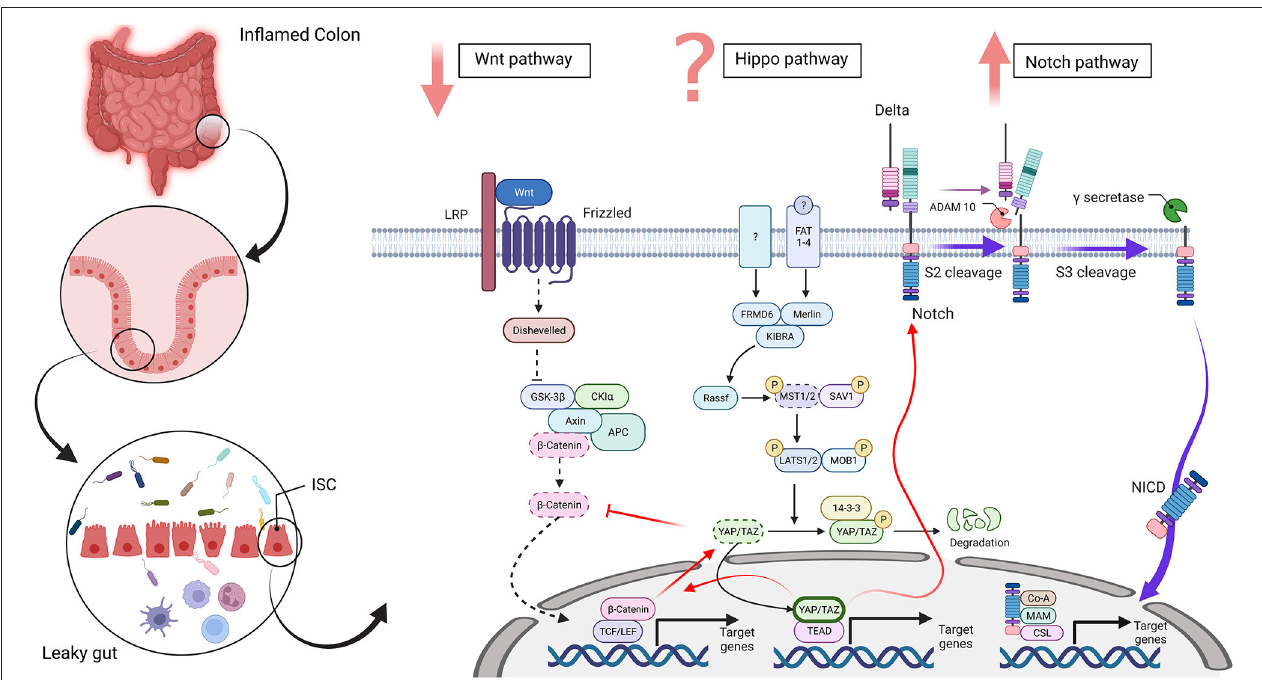
FIGURE 1 | Wnt, Hippo, and Notch signaling in an intestinal stem cell [inflammatory bowel disease (IBD) condition]. The disrupted intestinal epithelial barrier promotes a leaky gut in inflammatory conditions, such as IBD. In this state, differentiation-related pathways, such as Wnt, Hippo, and Notch, are dysregulated in intestinal stem cells. The Wnt signaling pathway plays a vital role in the intestinal epithelium and downregulation of β -catenin disrupts the differentiation of secretory cells in IBD. The Hippo pathway regulates cell proliferation, survival, apoptosis, and stemness. An improved amount of nuclear YAP/TAZ occurred in IBD and increased the proliferation of undifferentiated intestinal stem cells (ISCs) and a lack of secretory cells. In contrast, cytoplasmic YAP/TAZ overexpression is seen in inflamed tissue. Also, MST1/2 is downregulated and disorganized villus structures and increased undifferentiated cells and dysplastic epithelia. However, it is controversial that Hippo pathway is upregulated or downregulated in IBD. The Notch pathway regulates the differentiation and development of cells, tissues, and organs by interactions among nearby cells. Upregulation of the Notch pathway in IBD inhibits differentiation of secretory cell lineages and abnormality in the expression of NICD in ulcers reduces the quantity of goblet cells in patients with ulcerative colitis (UC). Red arrows show crosstalk between these three pathways and dotted lines display downregulated pathways and molecules. Abbreviations: low-density-lipoprotein-related protein (LRP), adenomatosis polyposis coli (APC), glycogen synthase kinase 3 beta (GSK3 β ), casein kinase 1 α (CK1 α ), T-cell factor (TCF), lymphoid enhancer factor (LEF), FERM domain-containing protein 6 (FRMD6), mammalian Sterile 20-related 1 and 2 kinases (MST1 and MST2), Salvador 1 (SAV1), Large tumor suppressor 1 and 2 kinases (LATS1 and LATS2), Mps One Binder Kinase Activator-Like 1A (MOB1), Yes-associated protein 1 (YAP), PDZ-binding motif (TAZ), TEA domain family member (TEAD), Fat-related atypical cadherins 1-4 (FAT 1-4), A Disintegrin and metalloproteinase domain-containing protein 10 (ADAM 10), Notch intracellular domain (NICD), meprin A-5 protein (MAM) and CBF1, Suppressor of Hairless, Lag-1 (CSL). The figure has drawn by BioRender